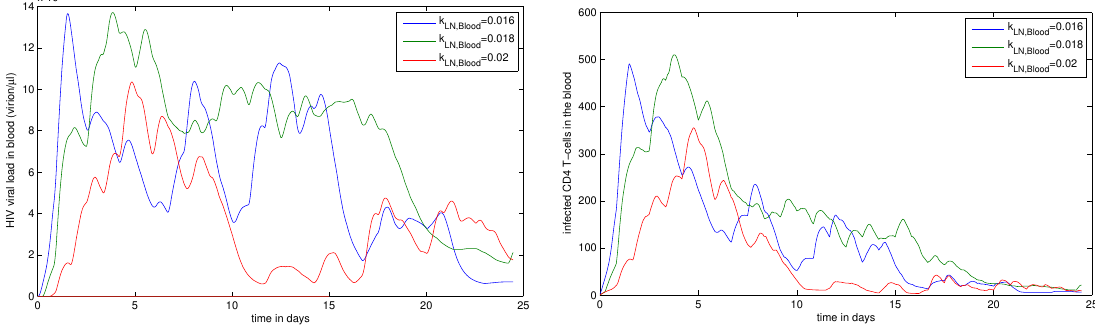
Figure 14. Sensitivity analysis for blood. The effect of the variation of the rate of CD8 + T cell migration from lymph node to blood ( k LN , Blood ) by ± 11%. ( left ) Viral load (virion/ µ L); ( right ) Infected CD4 + T cells (cell/ µ L).